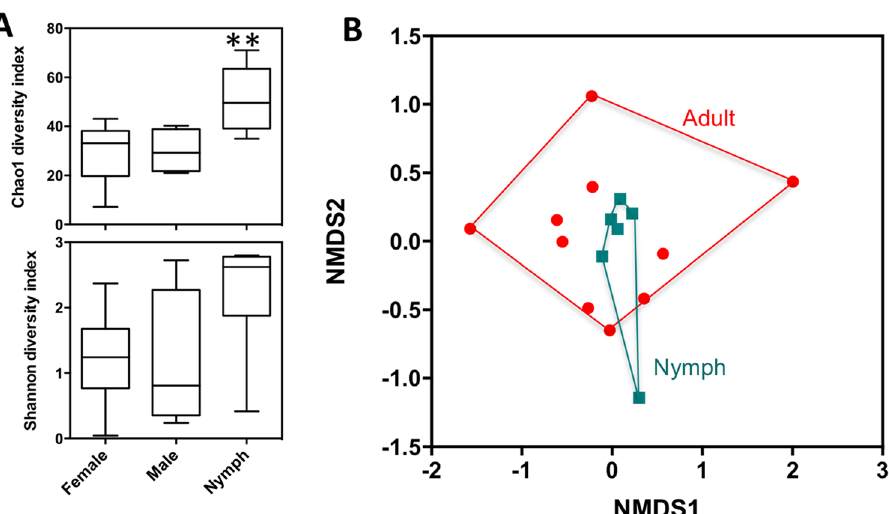
Figure 7. Microbiota diversity in T. dimidiata . ( A ) Alpha diversity assessed by Chao1 (top panel) and Shannon (Bottom panel) indices. Nymphs presented a significantly higher diversity based on Chao1 index (F = 5.82, P = 0.015), but not according to Shannon index (F = 2.64, P = 0.11). ( B ) NMDS analysis of beta diversity between adults and nymphs, indicating a significant difference in microbiota composition (PERMANOVA F = 1.84, P =